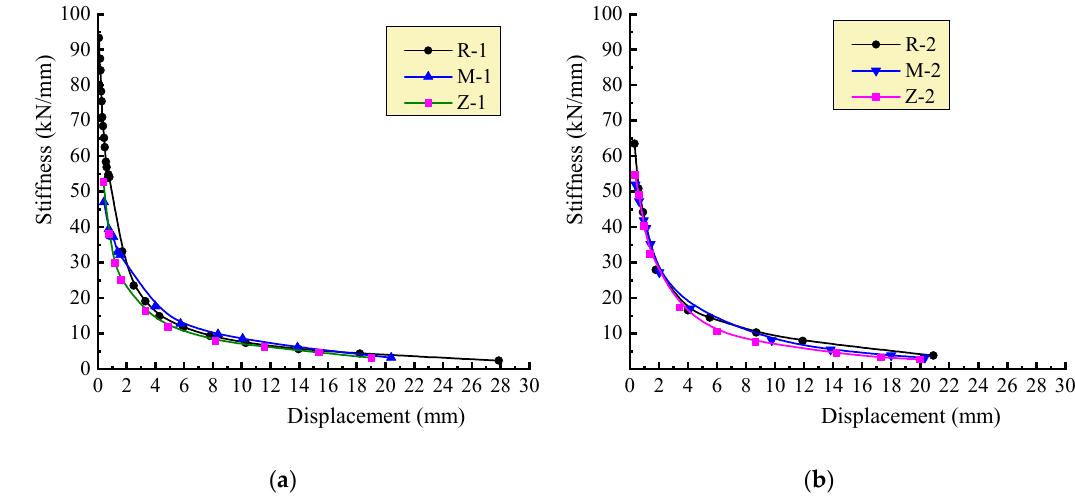
= 0.3 MPa; ( b ) σ = 0.5 0 0